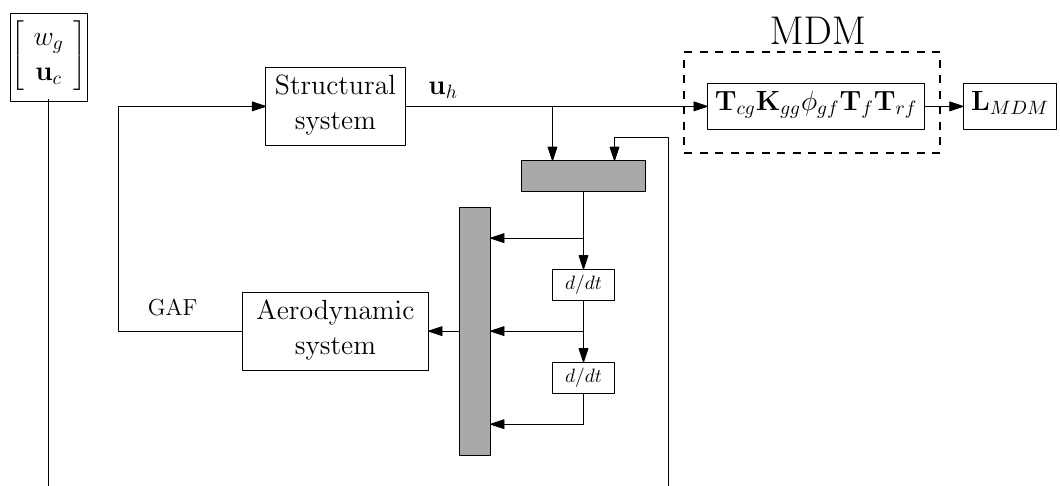
Figure 6. Mode displacement method (MDM).